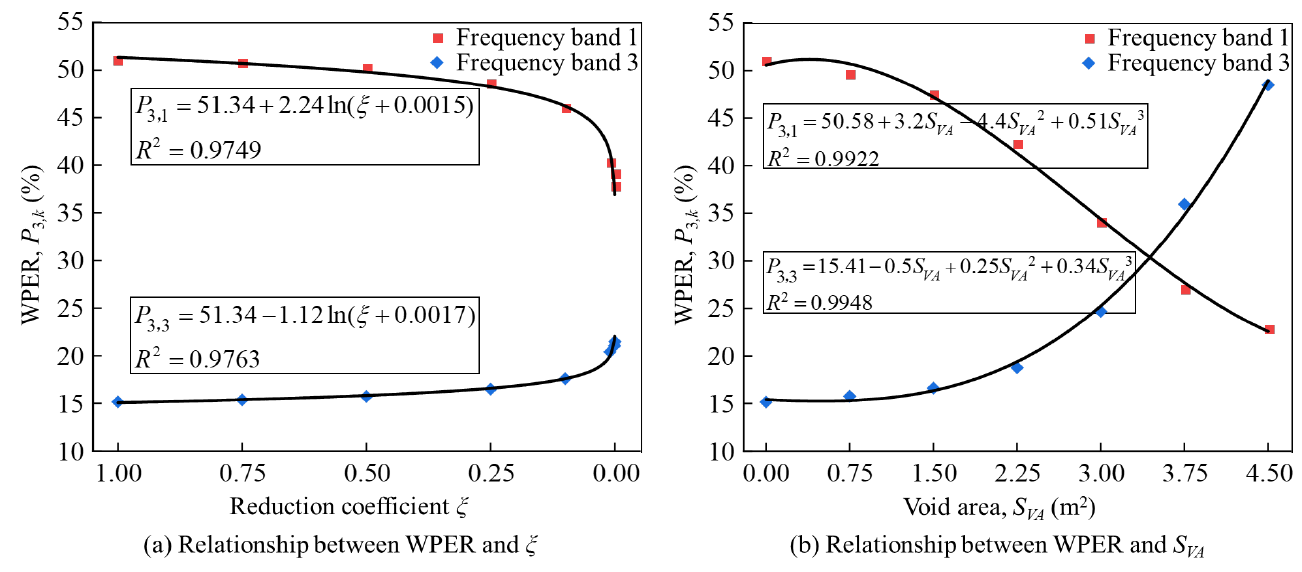
Figure 16. The change in the WPERs of frequency bands 1and 3 of the signal at monitor point 3.